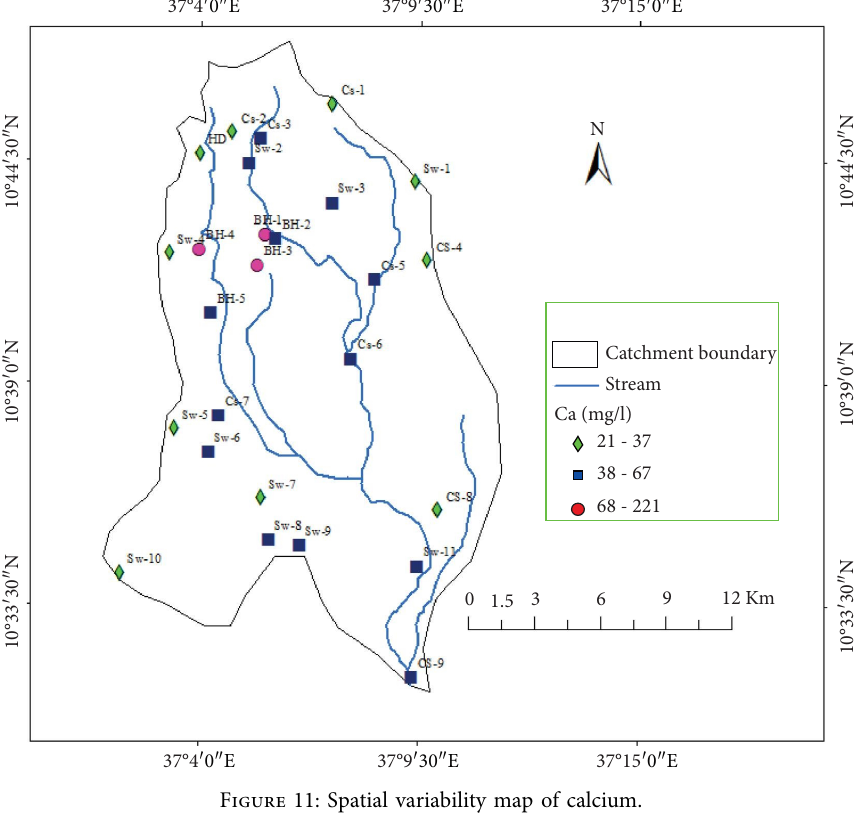
Figure 11: Spatial variability map of calcium.